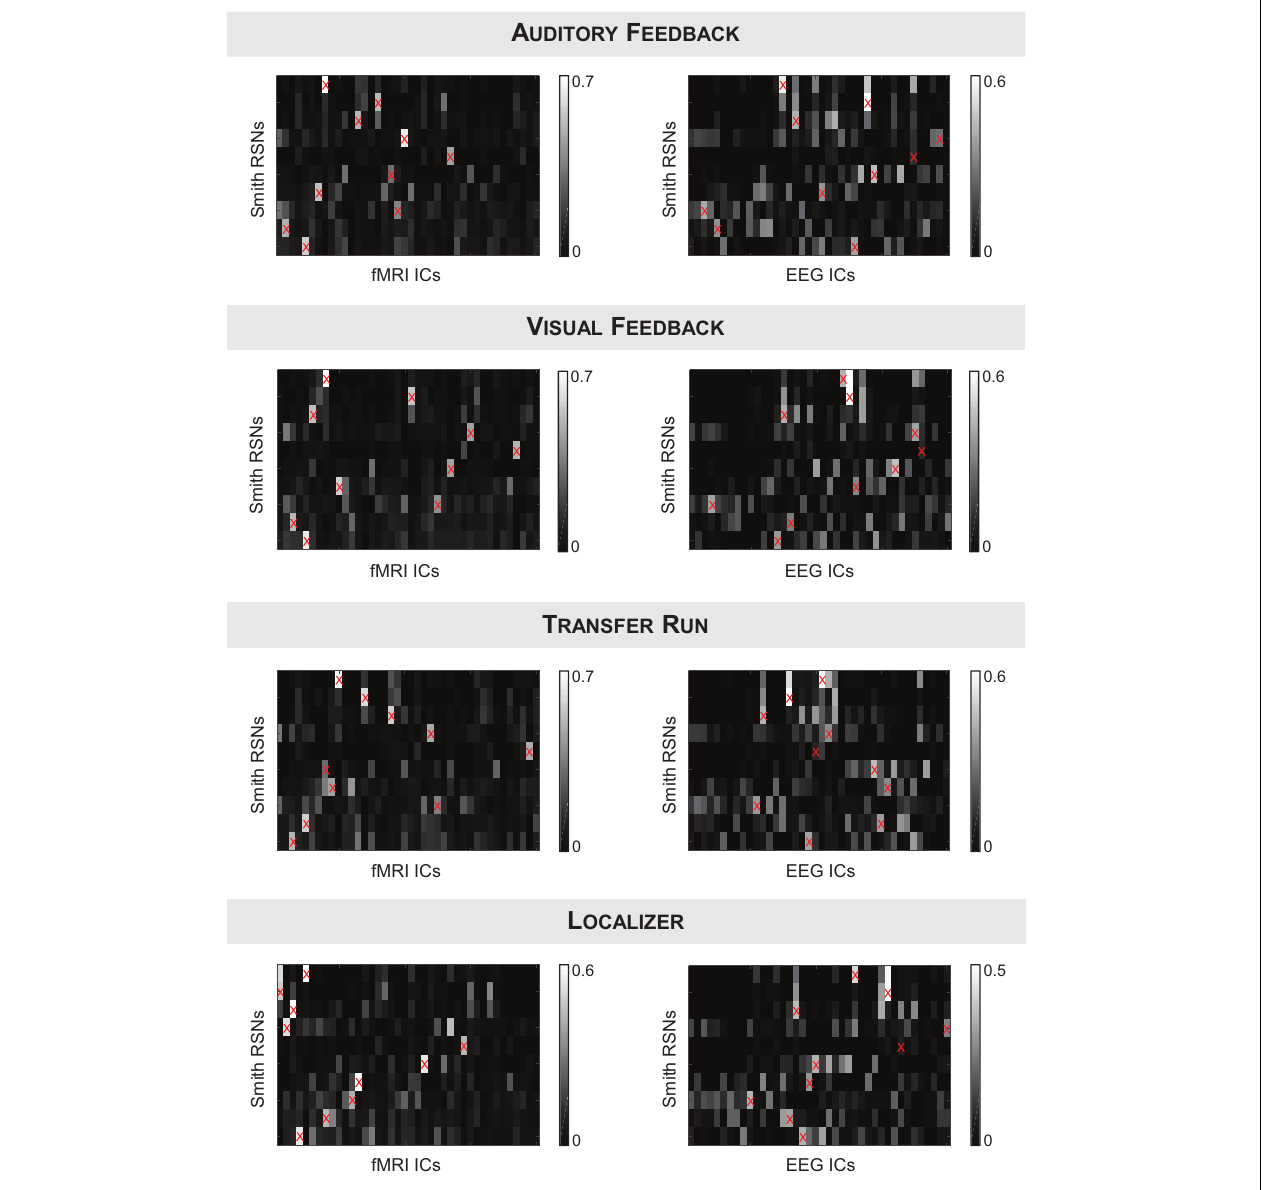
FIGURE 3 | Dice coefficients between all possible combinations of (left) fMRI ICs or (right) EEG-ESI ICs ( x -axis) and the RSN templates ( y -axis) from Smith et al. (2009), for the (from top to bottom) auditory feedback, visual feedback, transfer, and localizer runs. fMRI/EEG-ESI ICs assigned to RSN templates are marked by a red